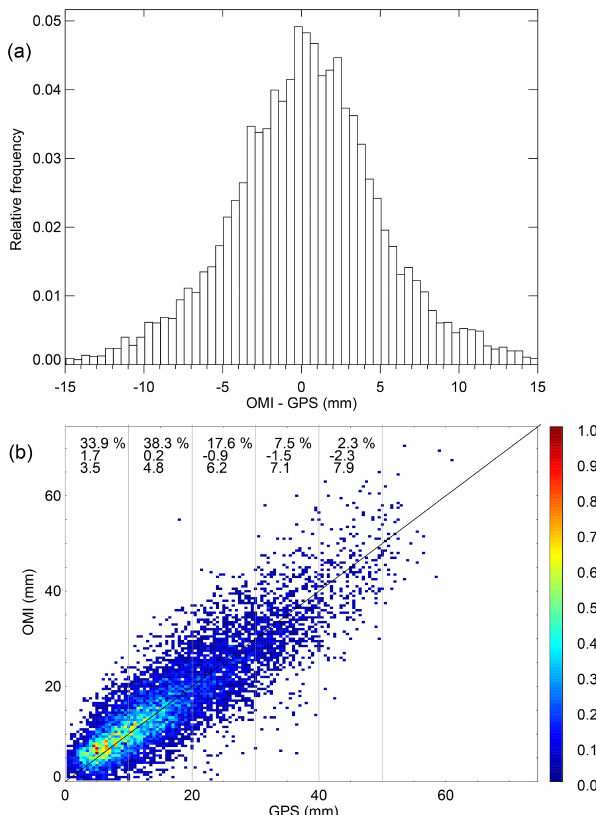
Figure 2. Comparison between colocated GPS and OMI TCWV (mm) for all days in 2006. The data filtering criteria include cloud fraction < 5%, cloud-top pressure > 750mb and others discussed in the text. (a) Relative frequency of occurrence for OMI–GPS (mm). (b) Normalized joint distribution of GPS versus OMI TCWV (mm). The three lines of text from top to bottom indicate the per- centage of data points (first), the mean of OMI–GPS in millimeters (second) and the standard deviation of OMI–GPS in millimeters (third) for each 10mm GPS TCWV, respectively. The 1 : 1 line is plotted for